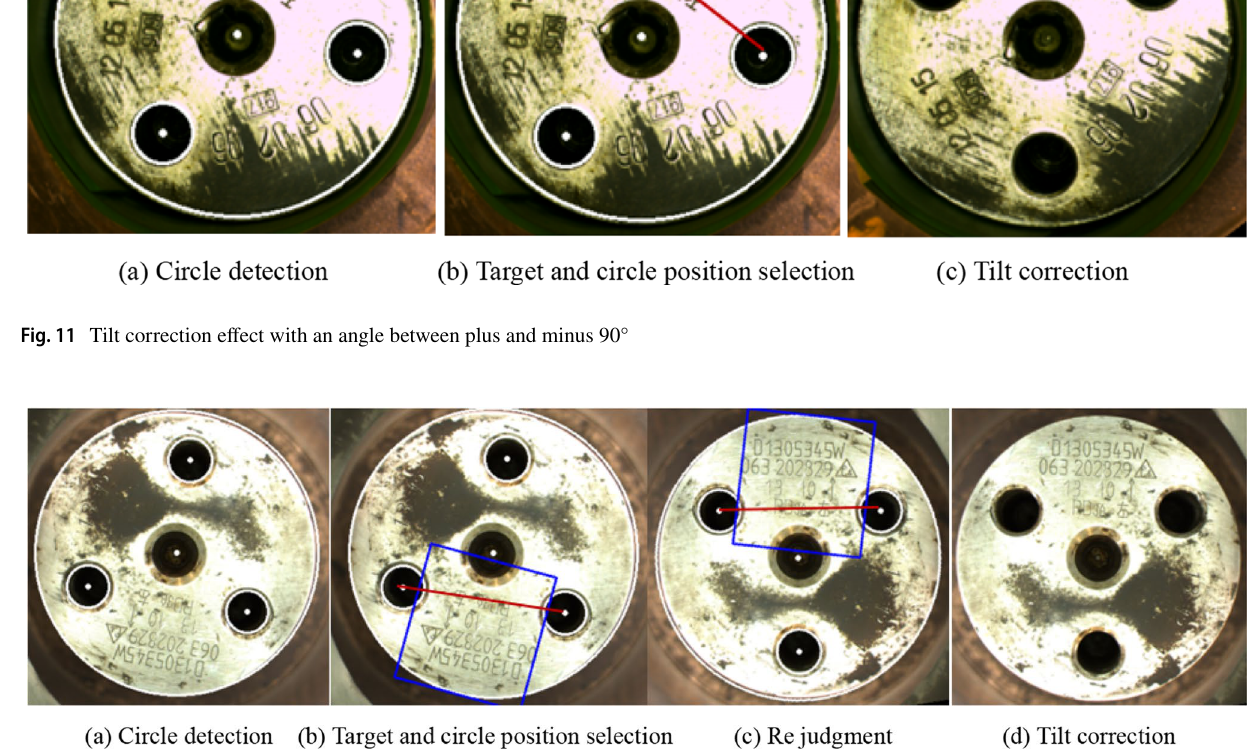
Fig. 12 Tilt correction effect when the angle is outside of plus or minus